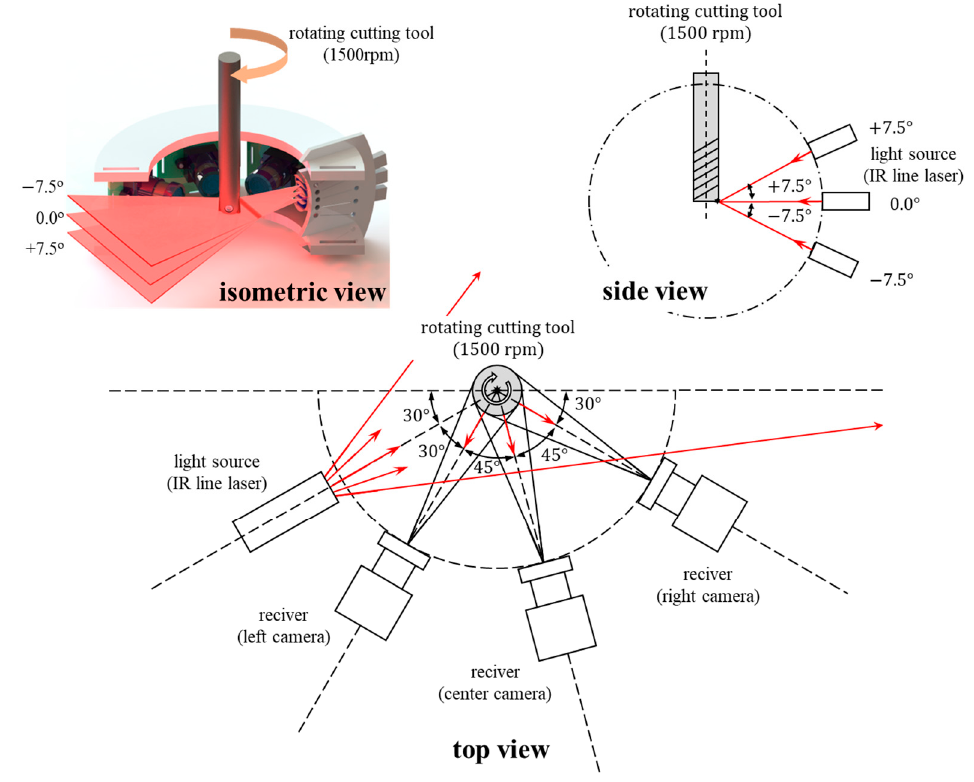
Figure 2. Proposed IR-reflection-based tool-wear-measurement device.